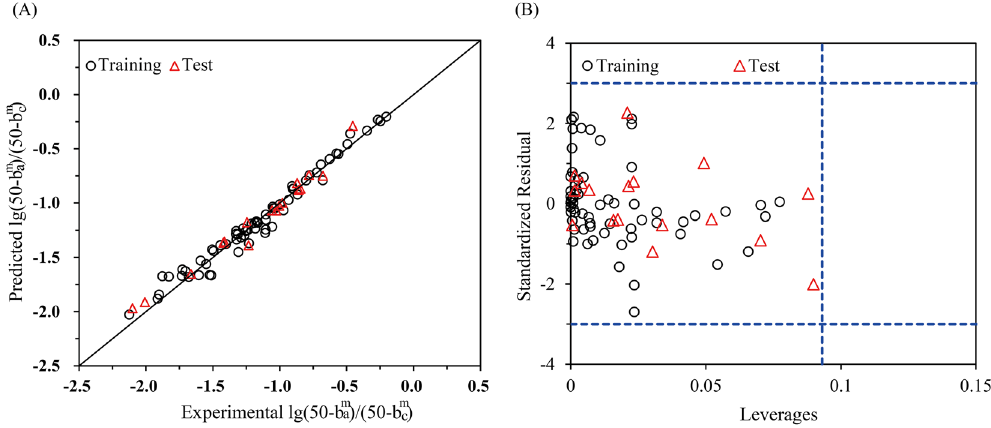
am 50 values. ( B ) Williams plot of the training and test lg b cm − b 50